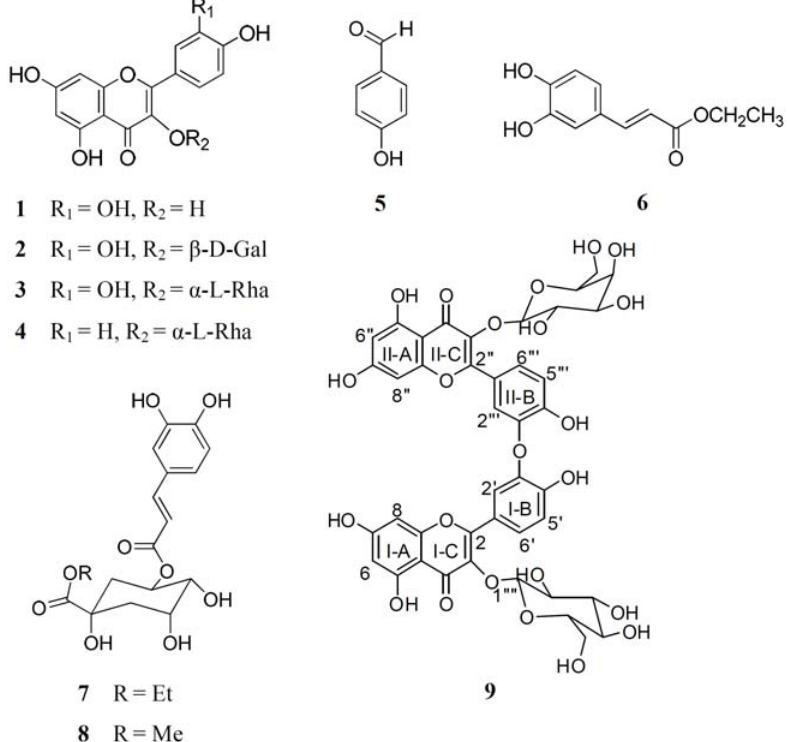
Figure 1. Chemical structures of compounds 1–9